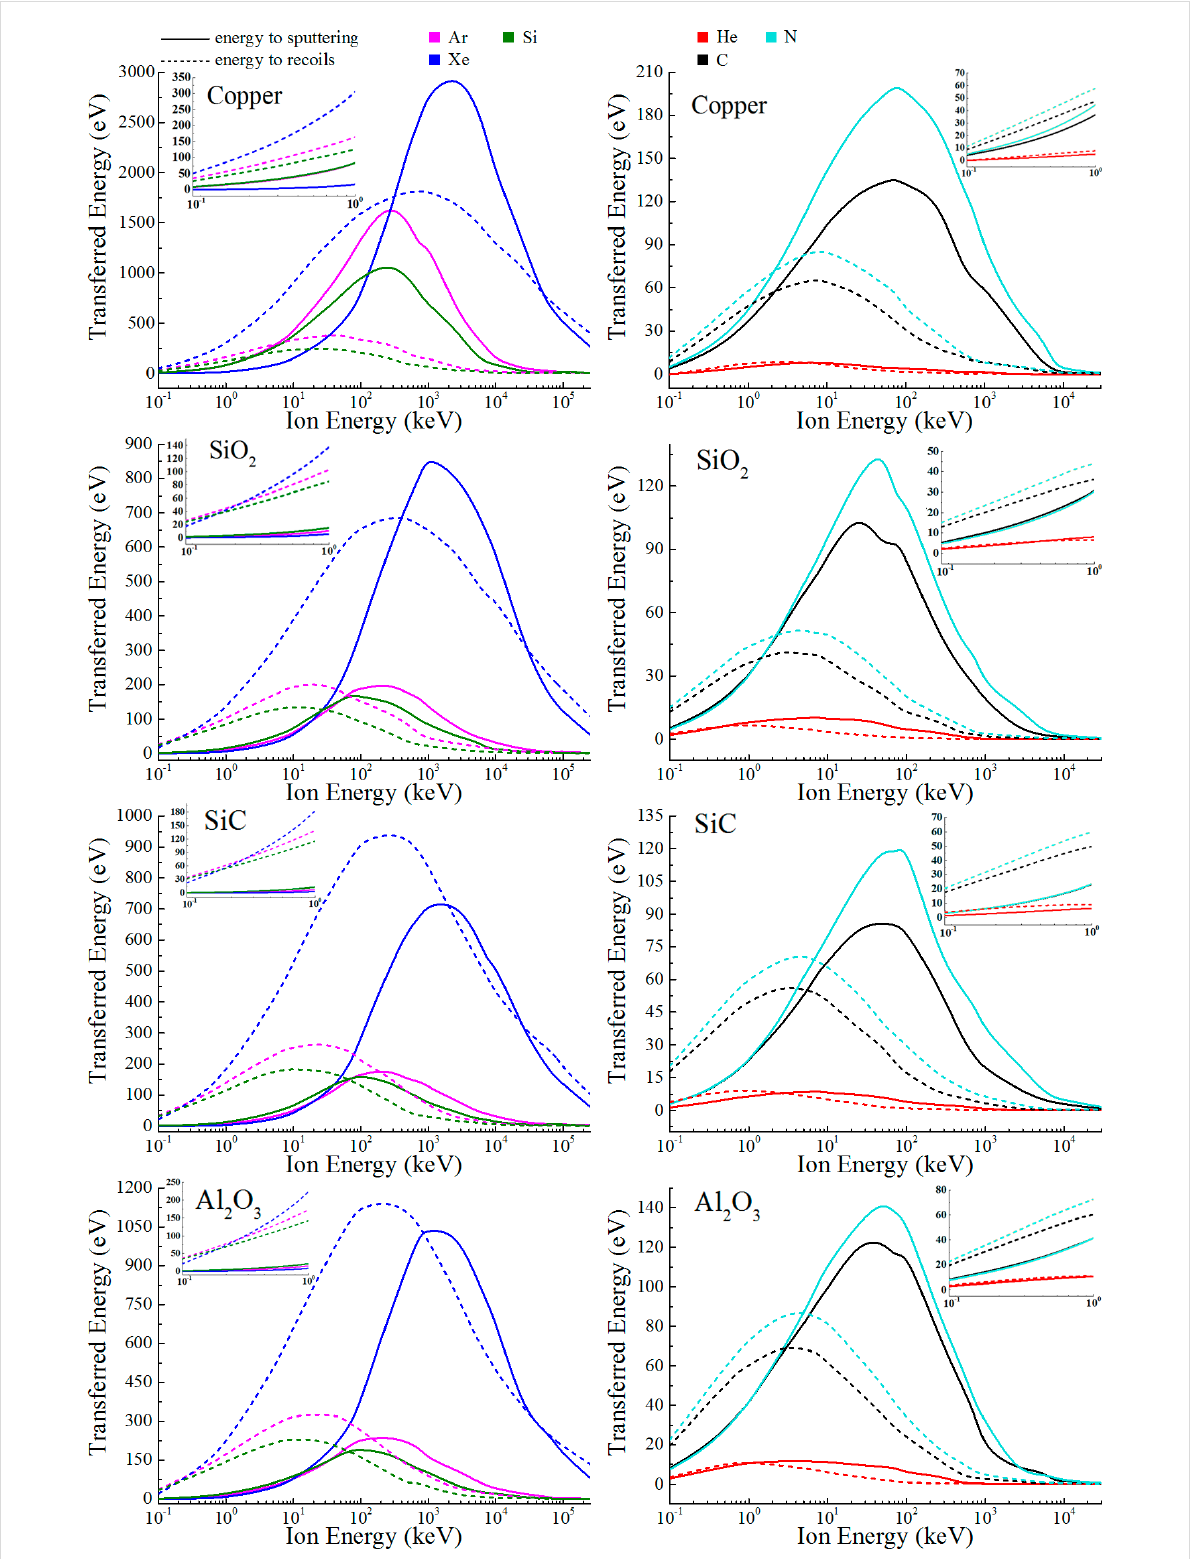
Figure 1: Energy transferred to substrate sputtering (solid lines) or substrate recoils reaching the interface while remaining within the substrate (dotted lines), as a function of the incident ion energy for Cu, SiO 2 , SiC and Al 2 O 3 substrates and He, Ar, Xe, C, N and Si